Question: Name the type of graph shown.
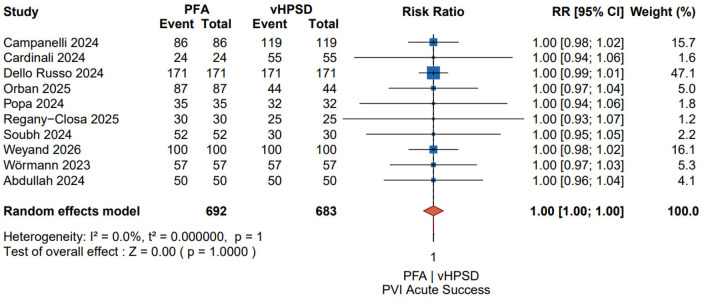
Answer: forest